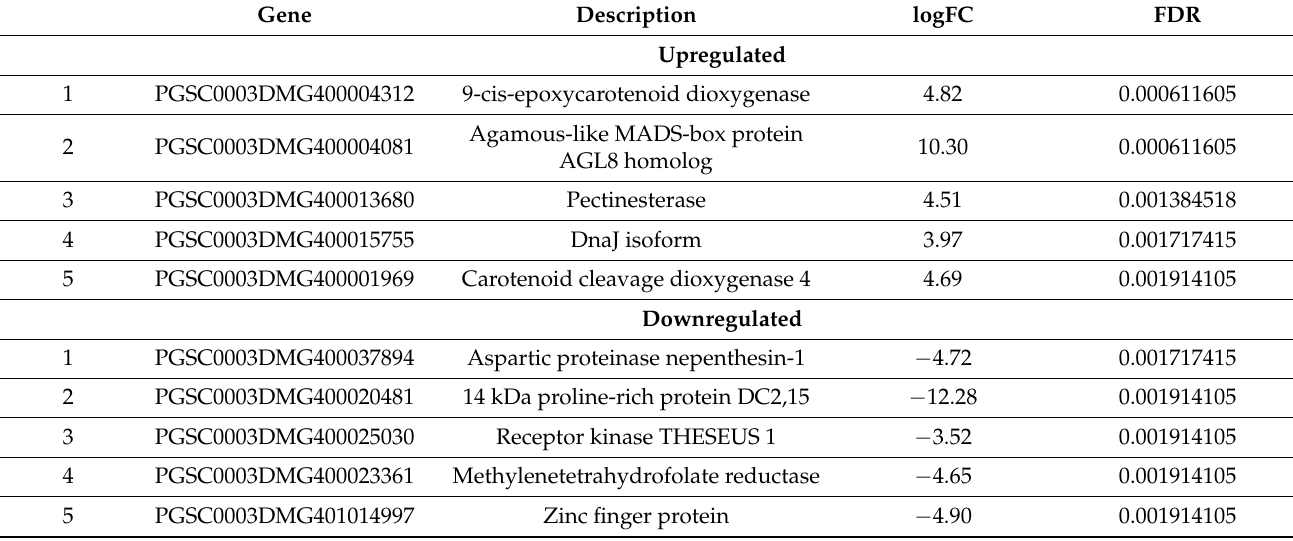
Table 4. Genes with the most significant difference in expression levels in potato leaves before inoculation (0 dpi) and at 30